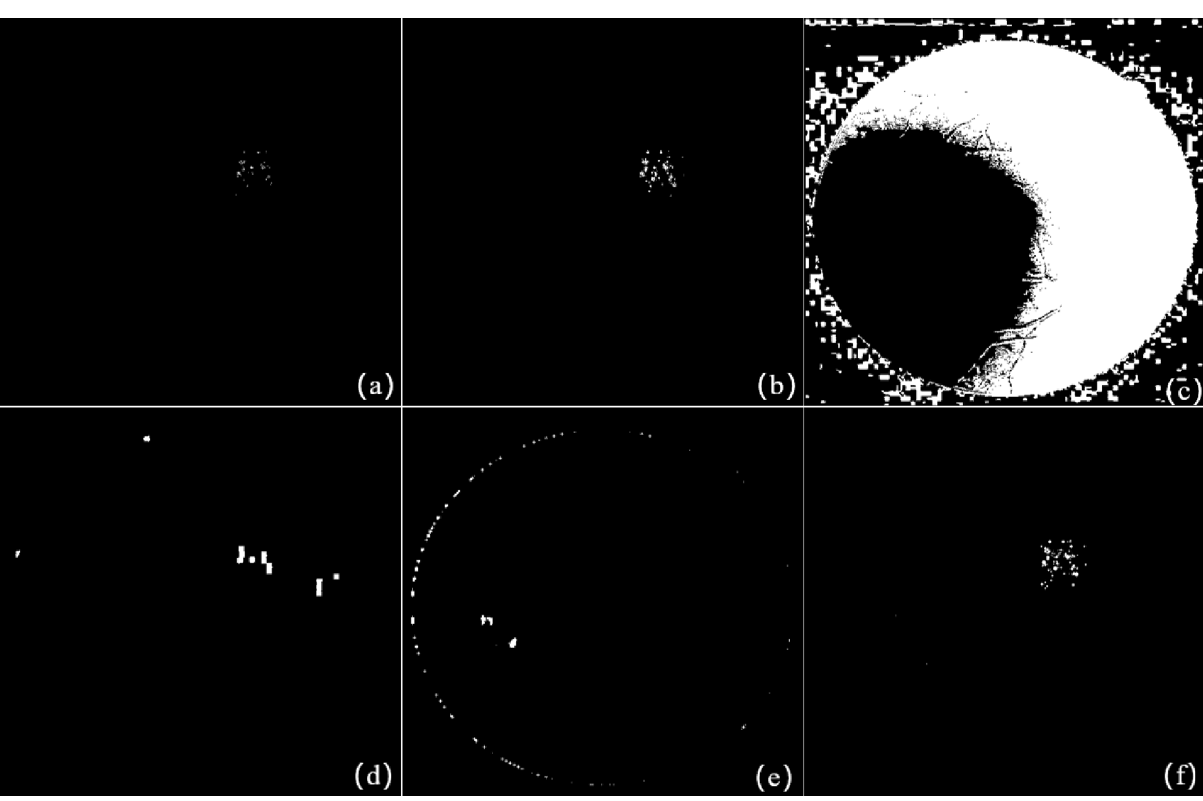
Figure 10. Binary CMs of the pair of images with small lesions in Fig. 9. ( a ) Binary CM of IRHSF; ( b ) binary CM of RPCA; ( c ) binary CM of NRELM; ( d ) binary CM of IRG-McS; ( e ) binary CM of NPSG; ( f ) binary CM of SRC.